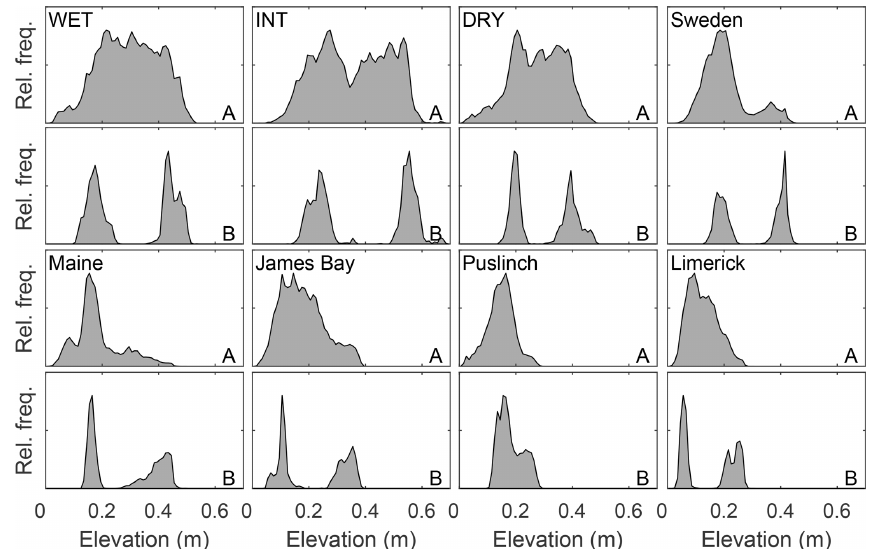
Figure 3. Plot-level relative frequency distribution of height in plots where a perceived representative hummock and adjacent hollow was subjectively chosen for a given site (Table 1 – qualitative plot locations). Relative height distributions are shown for all of panel (a) and for a hummock and hollow panel (b) , whose area corresponds to the size of a large flux measurement chamber. Elevations are referenced to the lowest point of the reconstructed surface and set to zero.